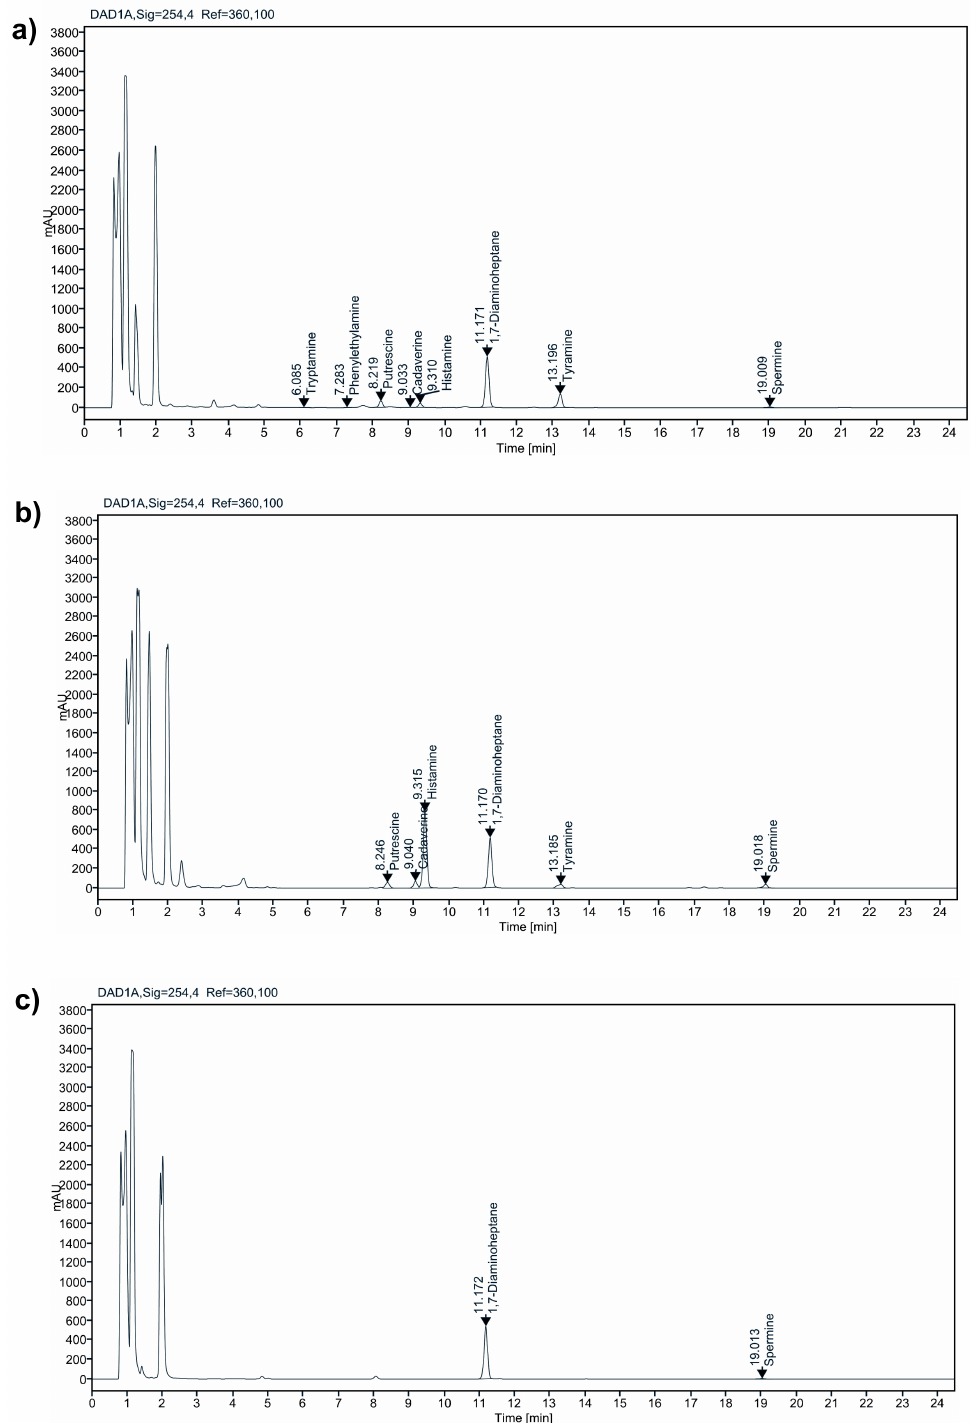
Figure 3. Representative chromatographic separation of biogenic amines in the imported ripened cheeses of Feta ( a ), Pecorino Romano ( b ), and Chevre ( c ) from the retail markets in the Republic of